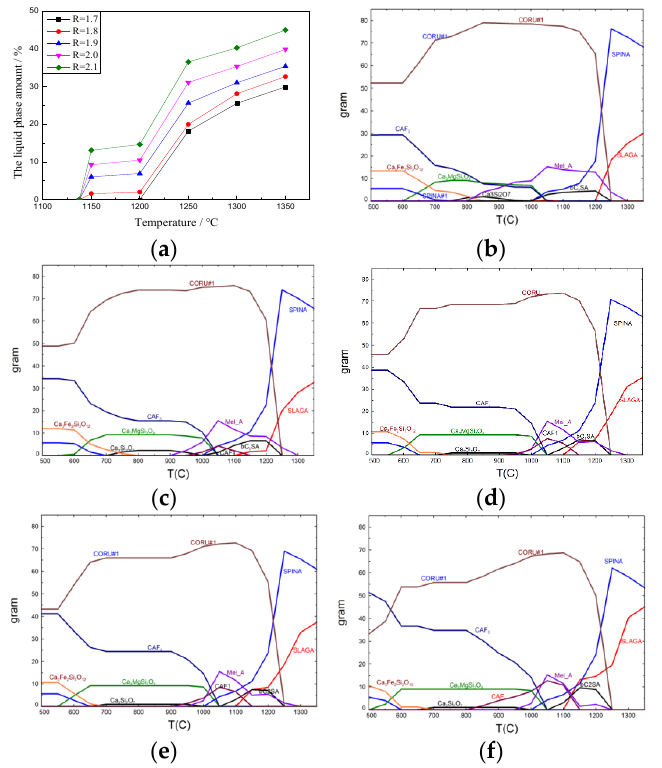
Figure 2. Mineral composition and liquid phase amount with different basicity values. ( a ) Liquid phase amount of sinter ( b ) R = 1.7 ( c ) R = 1.8 ( d ) R = 1.9 ( e ) R = 2.0 ( f ) R = 2.1.